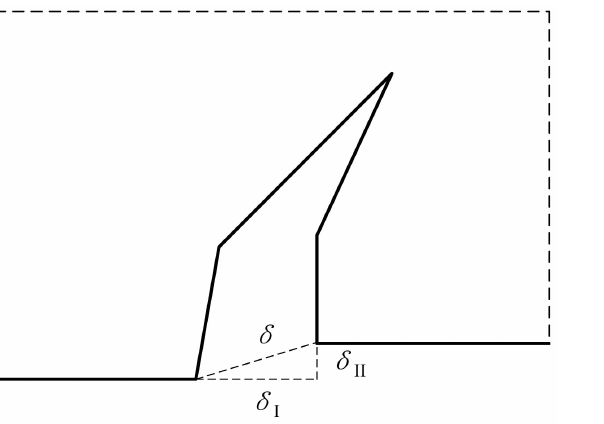
Figure 5. Application of the modified double-K fracture criterion in the I-II mixed mode